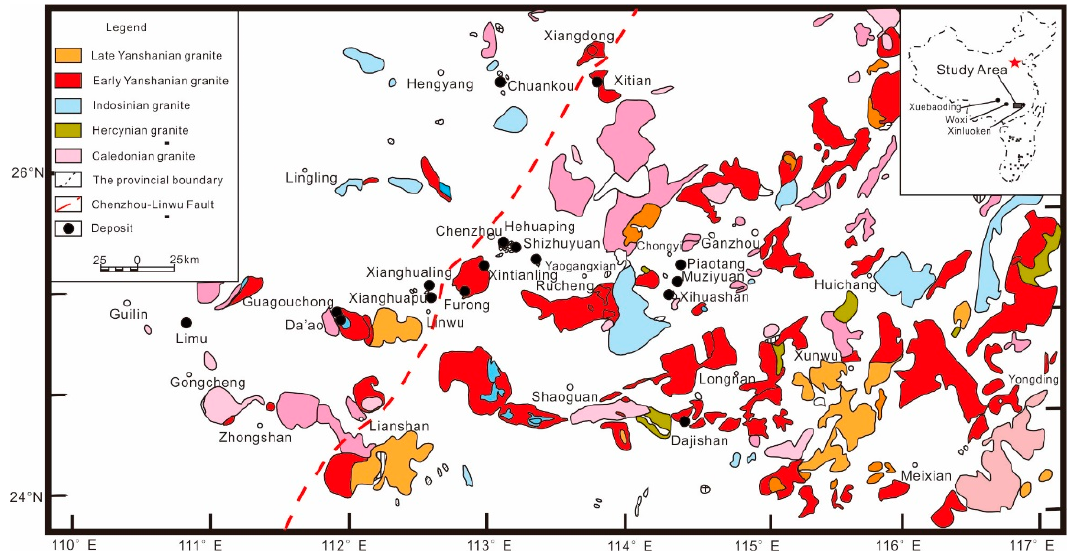
Figure 1. Sketch geological map of the Chuankou tungsten deposit (modified after [27]) showing the location of the Chuankou tungsten deposit and some important intrusion-related tungsten deposits in South China, such as the Limu tungsten deposit in Guangxi Province; Guagouchong, Da’ao, Xianghuapu, Xianghualing, Furong, Xintiangling, Shizhuyuan, Hehuaping W deposit in Hunan Province; Dajishan W deposit in Guangdong Province; and the Xihuashan, Muziyuan, Piaotang W deposits in Jianxi Province. Note, most deposits are associated with granite